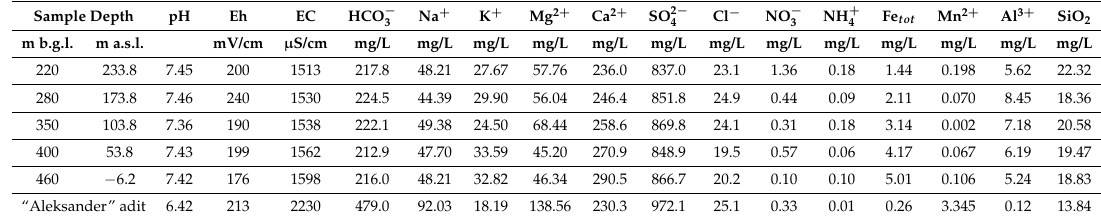
Table 1. Physicochemical analyses of water samples from the flooded “Nowy I” shaft—major constituents. Sample Depth